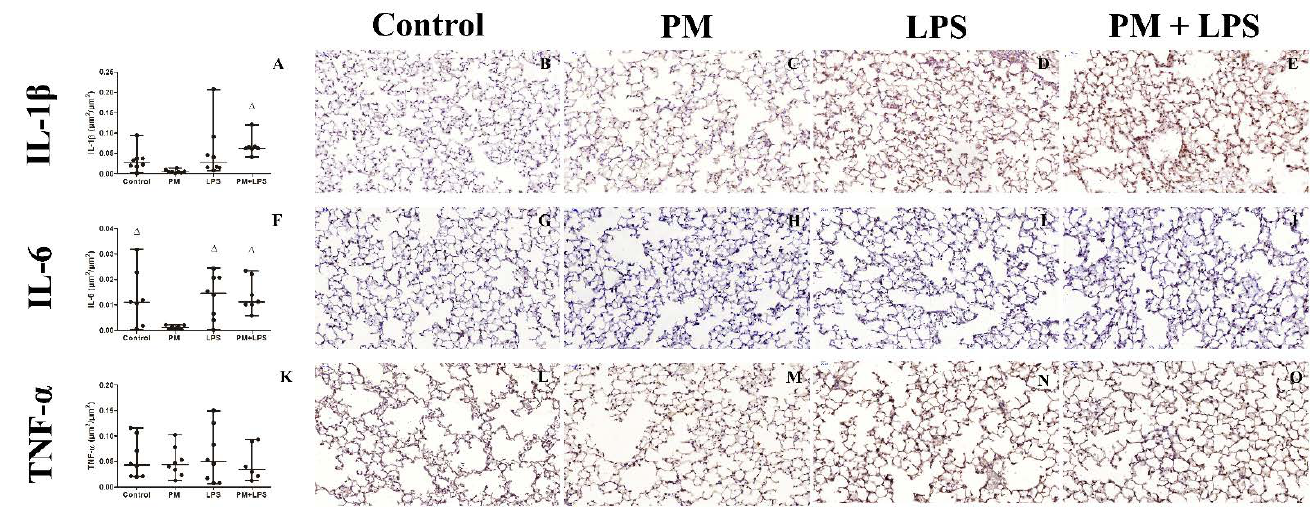
Figure 4. Graphical representation of IL-1 β , IL-6, and TNF α assessment in the lung parenchyma and representative photomicrographs of immunostained lung tissue. ( A ) Graphical representation of IL-1 β in the lung parenchyma. Representative photomicrographs of the lung parenchyma immunostained with anti-IL-1 β antibody: ( B ) control group, ( C ) PM group, ( D ) LPS group, and ( E ) PM+LPS group. The PM+LPS group exhibits intense positive stains for IL-1 β mostly in the epithelial cells, while in the LPS group the positive stains for IL-1 β are mostly in inflammatory cells. ( F ) Graphical representation of IL-6 in the lung parenchyma. Representative photomicrographs of the lung parenchyma immunostained with anti-IL-6 antibody: ( G ) control group, ( H ) PM group, ( I ) LPS group, and ( J ) PM+LPS group. The LPS group exhibits positive stains for IL-6 mostly in the inflammatory cells and epithelial cells, while in the control and PM+LPS groups the positive stains for IL-6 are mostly in epithelial cells. ( K ) Graphical representation of TNF- α in the lung parenchyma. Representative photomicrographs of the lung parenchyma immunostained with anti-TNF α antibody: ( L ) control group, ( M ) PM group, ( N ) LPS group, and ( O ) PM+LPS group. Positive stains for TNF α are mostly in the epithelial cells. Each point of the graph represents one animal and bars show the median. ∆ p < 0.05 compared to the PM group. Scale bars = 50 μm.